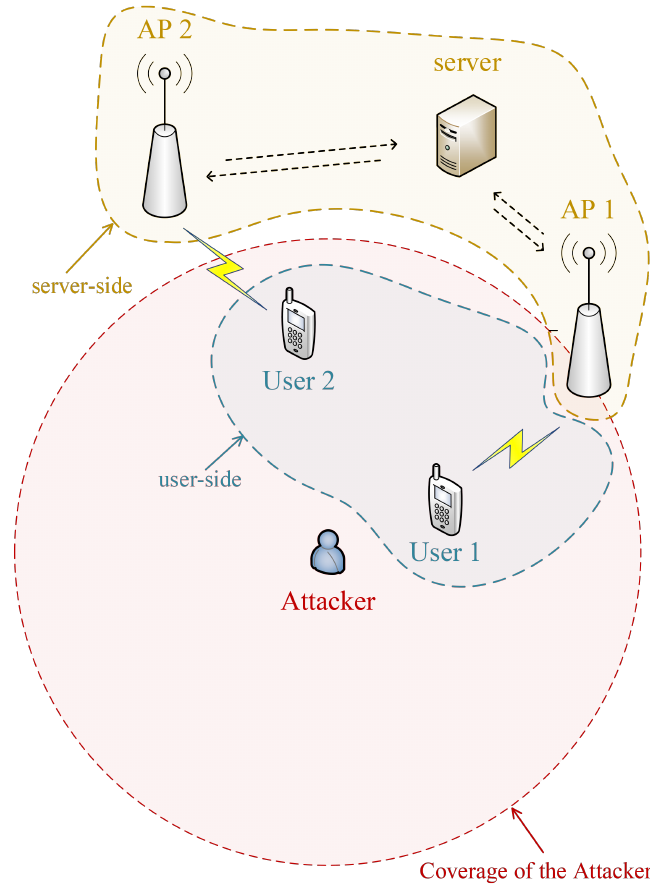
Figure 1. System and threat